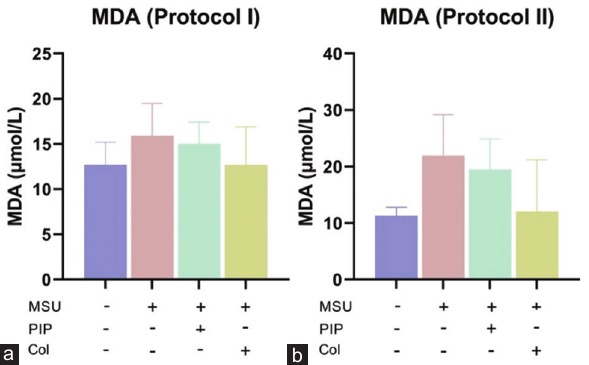
a Fig ure-5: Oral administration of piperine inhibits lipid peroxidation due to monosodium urate-induced gout inflammation, thereby suppressing malondialdehyde (MDA) levels. (a) Serum MDA levels in protocol I. (b) Serum MDA levels in protocol II. Values on the graph are represented as mean±SD (n=3 rats/group).